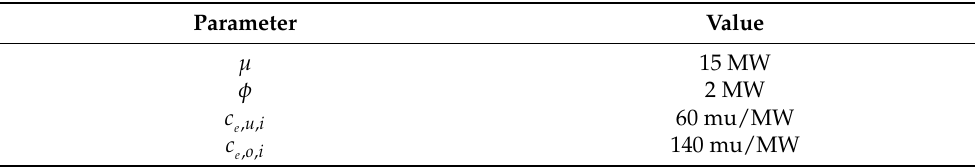
Table 12. Parameters taken for the controllable load cost function